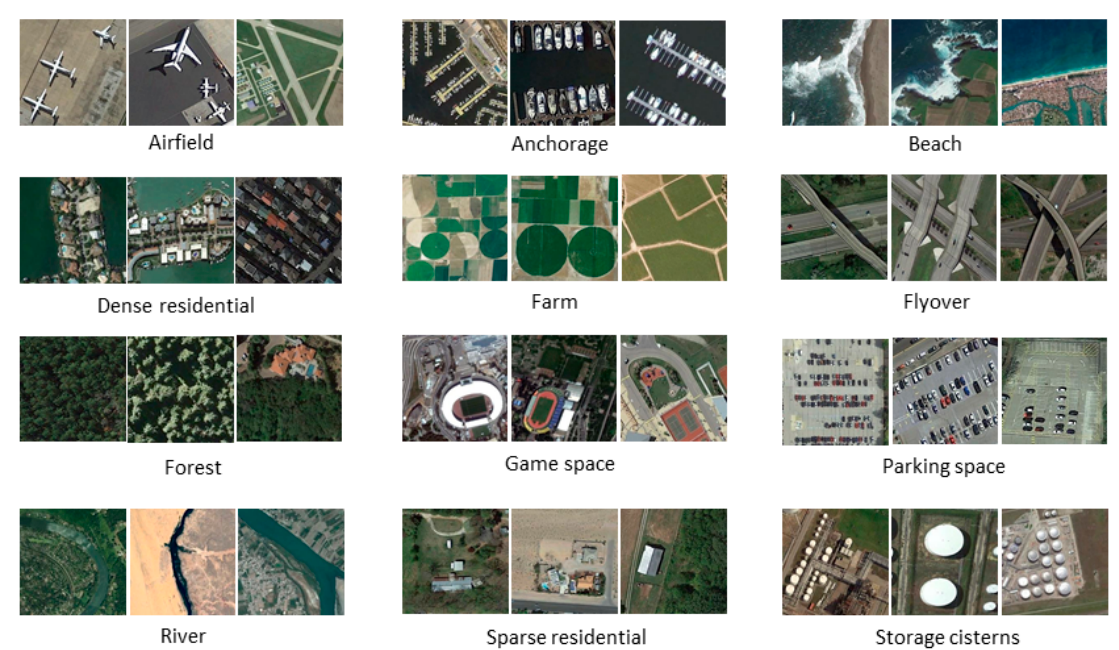
Figure 7. Example of images extracted from NWPU dataset.